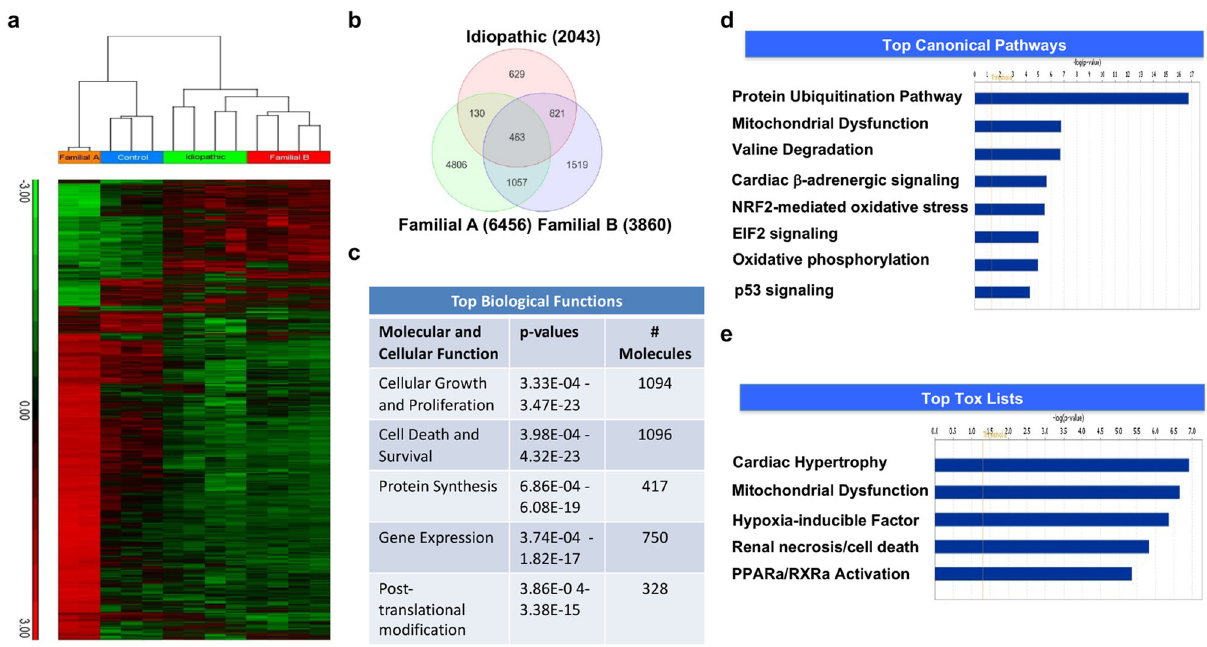
Fig. 1 Global gene expression analysis of differentially regulated genes in the four groups of hearts. a Two-dimensional hierarchical clustering of signi fi cantly dysregulated genes in heart samples from FDC patients (Familial A) carrying the FBXO32 mutation, FDC from a second family with a different genetic mutation, and idiopathic heart samples compared to control hearts. Red and green denote highly and weakly expressed genes, respectively. For Family A and B, samples are from one heart run in duplicates and quadruplicates, respectively. Control and idiopathic dilated hearts (IDC) are from 3 and 4 different individuals, respectively. b Venn diagram illustrating genes signi fi cantly dysregulated in patient group in comparison to the control group. Circles illustrate the number of genes common or unique to each speci fi c group of hearts. Of the transcripts signi fi cantly dysregulated, 4806 genes were unique to Family A with the FBXO32 mutation. c Top enriched biological processes, functions, and pathways in the FBXO32 mutant heart. d , e IPA functional analysis of the differentially expressed genes in the mutant FBXO32 heart of Family A. The Graphs represent top signi fi cant canonical pathways ( d ) and toxicology functions ( e ). X -axis indicates the signi fi cance ( – log10( p -value)) of the functional association. The threshold line represents a p value of